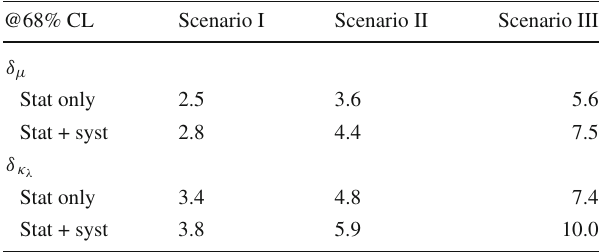
Table 4 Expected precision at 68% CL on the di-Higgs production signal strength and Higgs self coupling using the b ¯ b γγ channel at